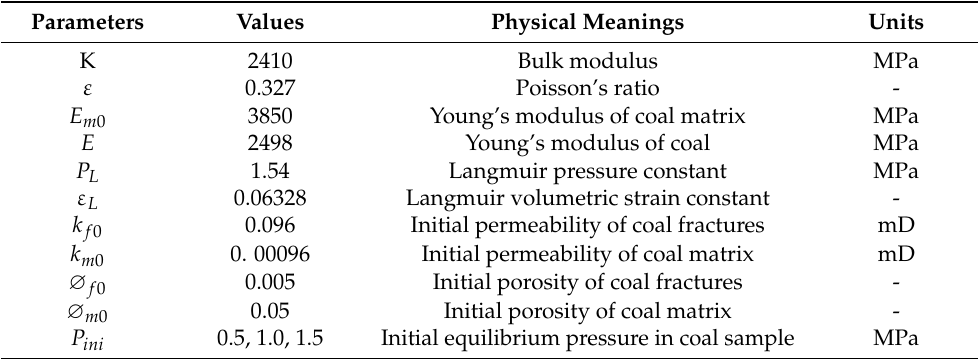
Figure 6. Numerical simulation results for Guhanshan coal. Table 2. Basic numerical simulation parameters for Guhanshan